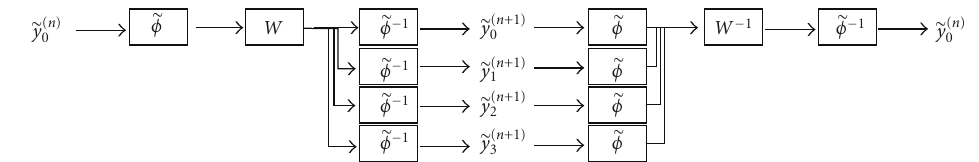
Figure 1: Parameterized Logarithmic Wavelet Transform analysis and synthesis.